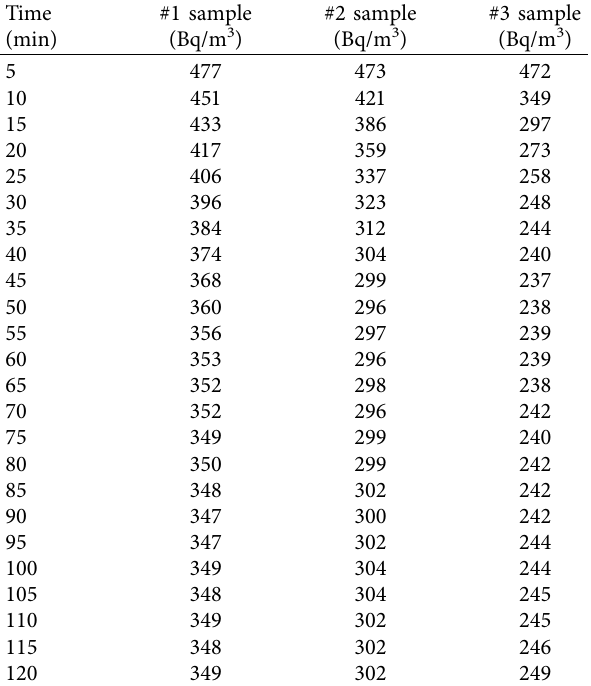
Figure 8: Axial deformation variation with axial strength for mudstone sample. Table 1: The measured radon concentrations of three samples.